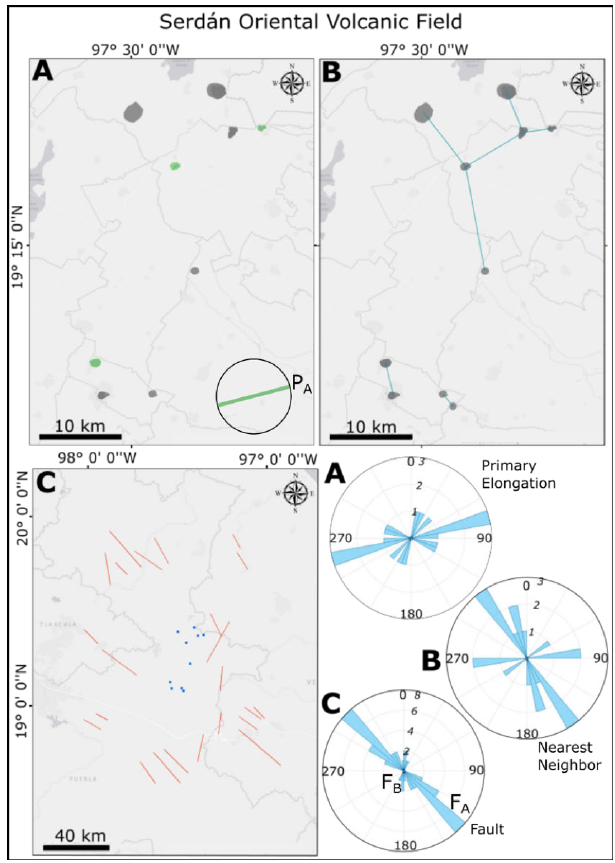
Figure 10: Serdán Oriental Volcanic Field spatial (map) and orientation data (rose diagram). [A] Maars mea- sured for primary elongation orientation. Colors indi- cate maar modes Green (PA), Grey (none). [B] Maar only nearest neighbor lines. [C] Location of all maars from a regional view (blue dots) and fault lines in the region (red lines). The east west structures of the Trans Mexican Volcanic Belt are not visible in the study area (Table